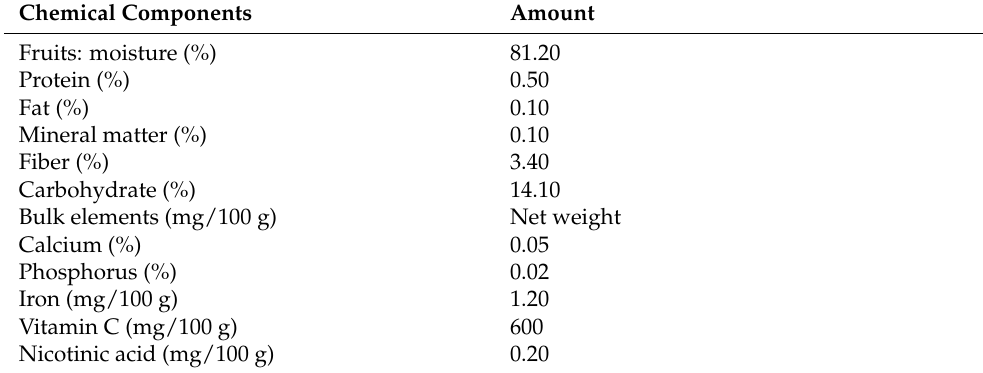
Table 4. Nutritional value of E. officinalis 1